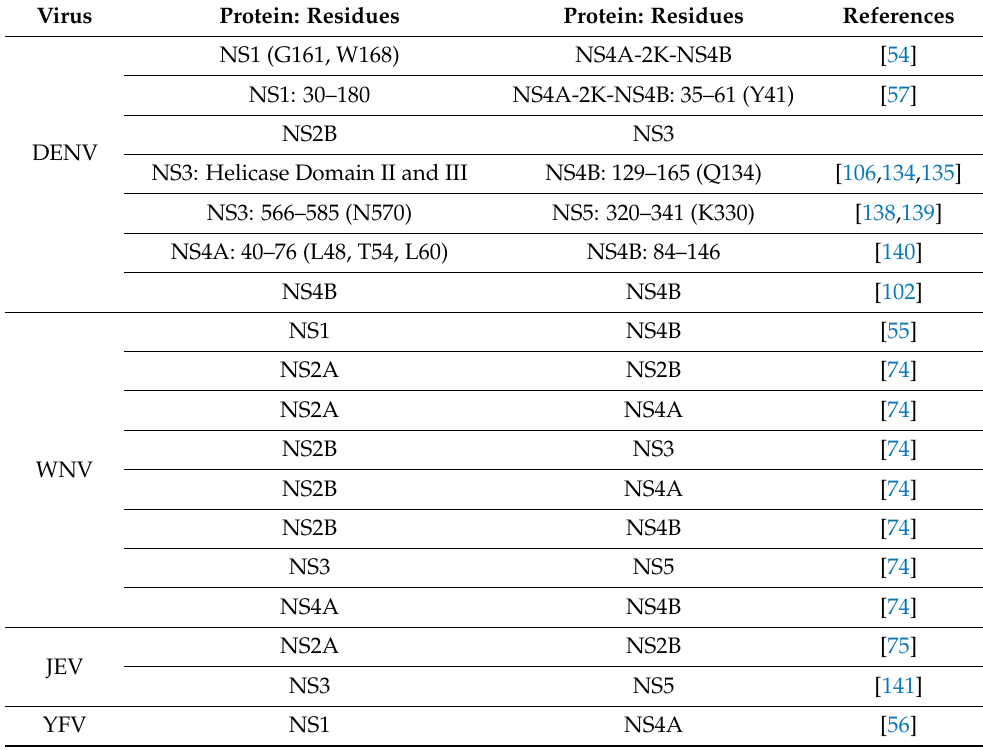
Table 4. Interactions between the NS proteins within the replication complex. Virus Protein: Residues Protein: